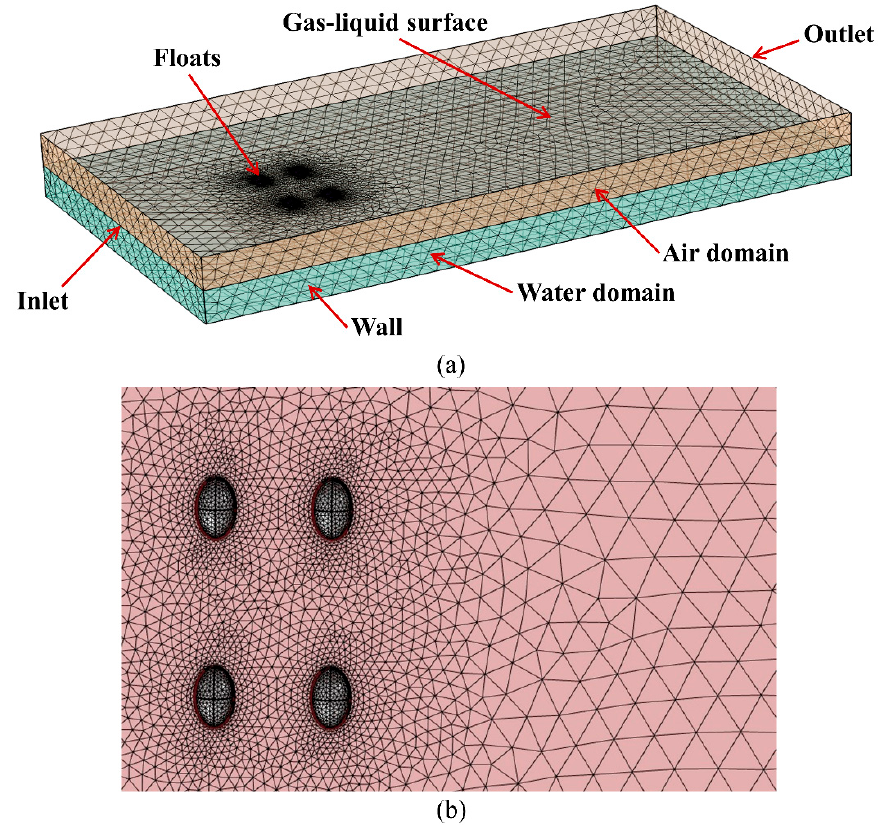
Figure 11. The computational fluid dynamics (CFD) two-phase flow model in COMSOL software: ( a ) overall of the model; ( b ) the area around the floats.